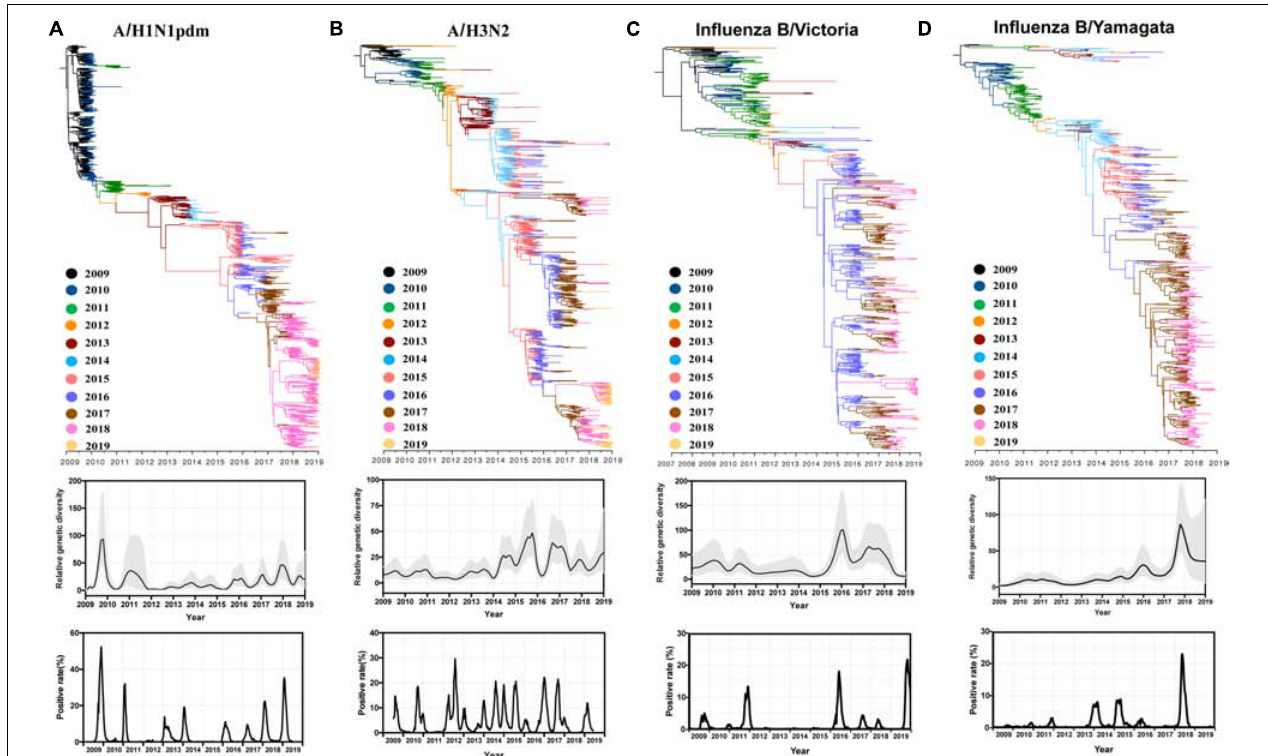
FIGURE 6 | Comparative phylogenetic analysis, population dynamics and positive rate of A/H1N1pdm (A) , A/H3N2 (B) , influenza B/Victoria (C), and influenza B/Yamagata (D) viruses. Phylogenies were inferred using the strict clock model and relative genetic diversity estimated using the Gaussian Markov Random Field (GMRF) model. The branches were colored by sampling year. Solid black lines in the GMRF plot represent mean relative genetic diversity, and the gray shades indicate the 95% HPD (highest probability density) intervals. The positive rate of A/H1N1pdm virus (2009–2019), A/H3N2 (2009–2019), influenza